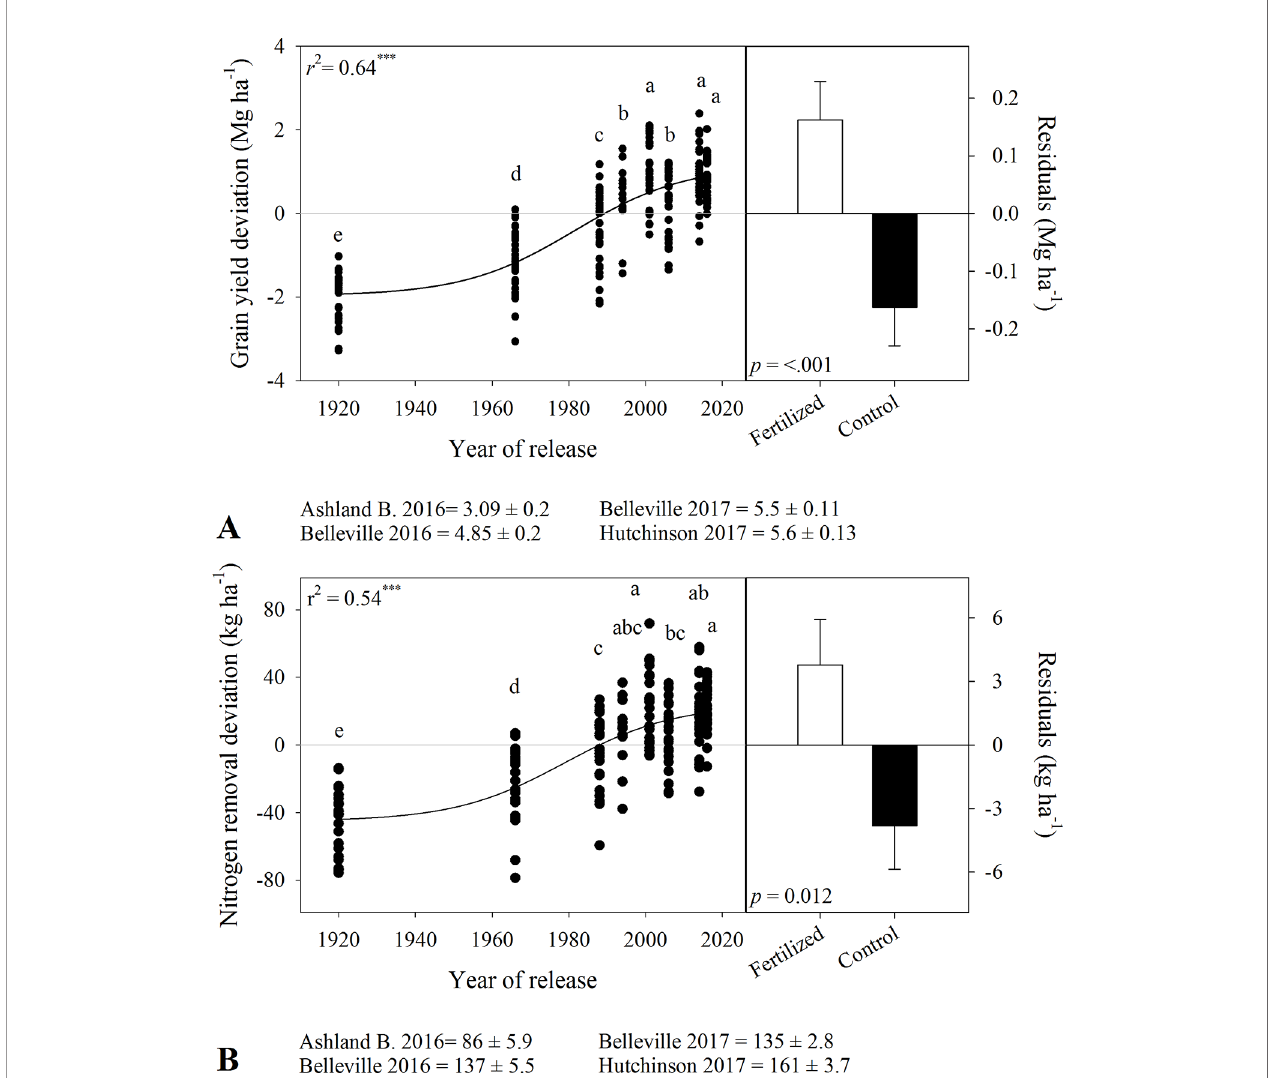
FIGURE 2 | Relationship between year of release and (A) grain yield deviation and (B) grain nitrogen removal deviation. Comparison of the residuals of the regressions for in-furrow fertilizer treatment and control (bars show mean and standard error). Values correspond to the data of four site-years during two growing seasons (2016-2017 and 2017-2018). Mean for all varieties in each site and year. Both curves are signi fi cant at P < 0.0001. Varieties followed by the same letter are not statistically different at a =